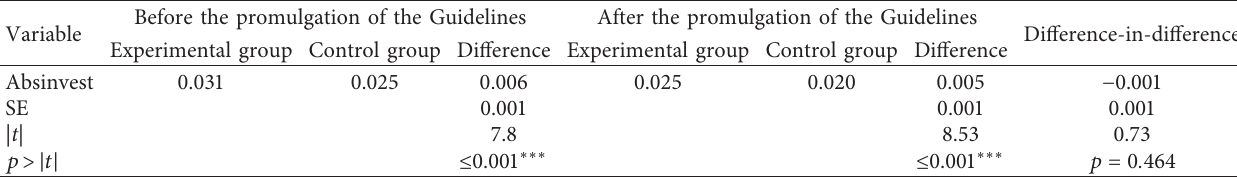
Table 10: Robust test (1).